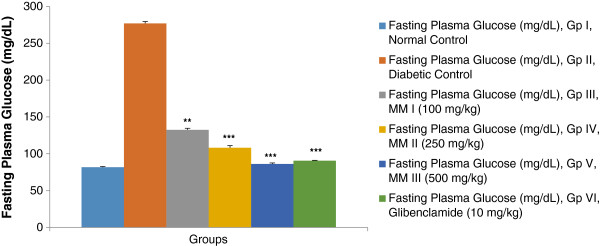
Effect of Melastoma malabathricum Linn. (MM) on fasting plasma glucose at different concentrations on STZ induced diabetic rats, compared to standard drug Glibenclamide; values are mean ± SEM; n = 6; *P < 0.05; **P < 0.01; ***P < 0.001; P > 0.05 is considered as non-significant (ns).